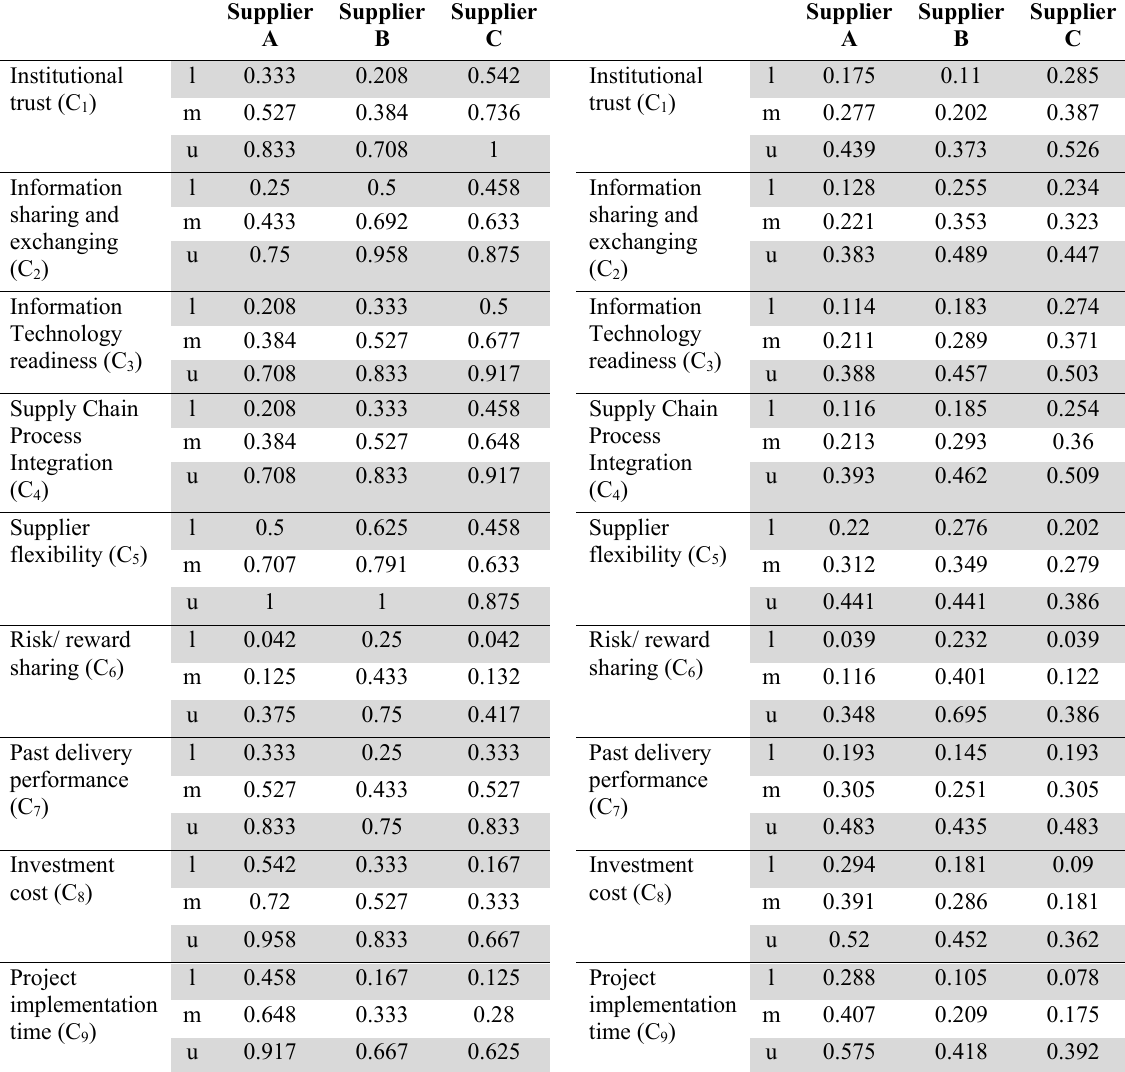
Fuzzy aggregated decision matrix between alternatives and criteria